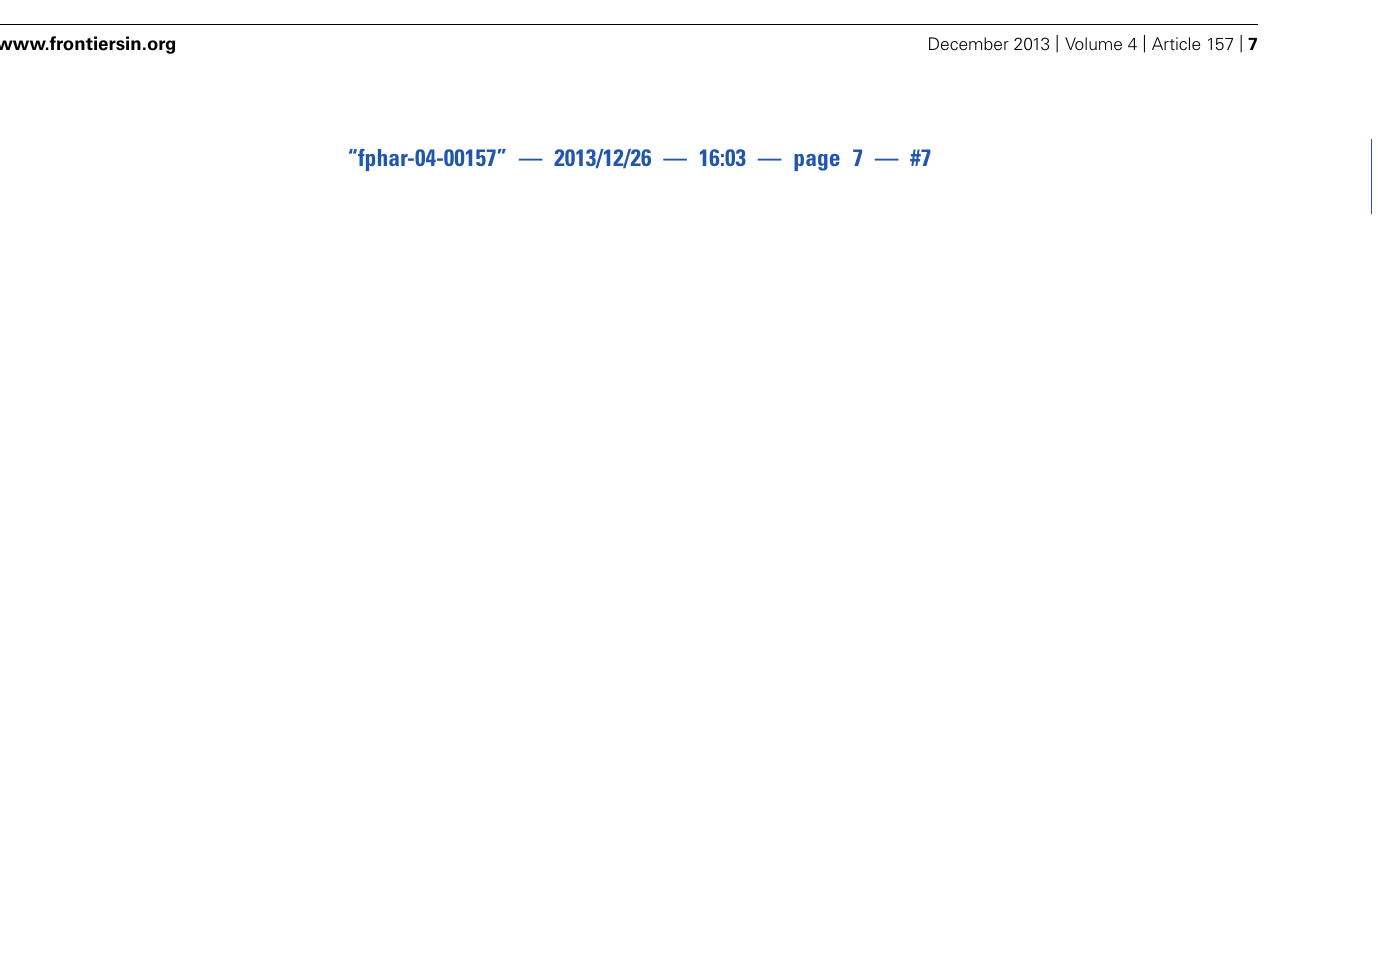
FIGURE 2 |Activatable low molecular weight protamine (ALMWP)- modified micelles allow for increased accumulation of paclitaxel in an intracranial C6 glioma model in nude mice. (A–C) In vivo fluorescence imaging taken of nude mice bearing intracranial C6 glioma tumors. Mice were injected intravenoulsy with DiR-labeled micelles (A) , LMWP-micelles (B) , and ALMWP-micelles (C) . (D) Images of organs taken from mice sacrificed 24 h